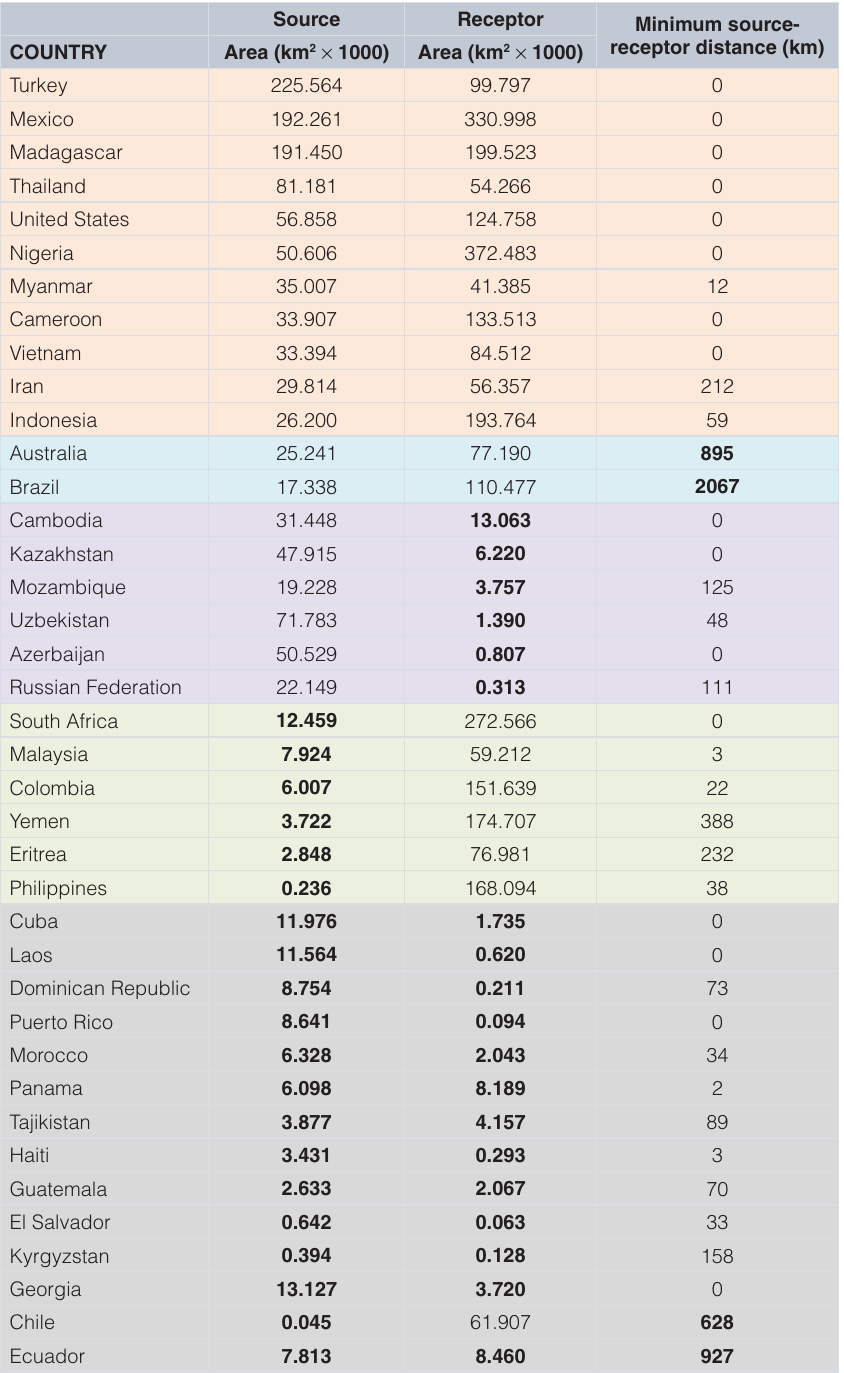
Table 1. Surface of and distances between source and receptor areas within countries where both types of areas are present. Countries were ranked from best to worst candidates based on size of source area, size of receptor area and minimum distance between the two. Orange background: best candidate countries based on thresholds of 15,000 km 2 for the areas and 500 km distance between areas. Numbers in bold correspond to limiting factors. Blue background: countries where distance between source and receptor may be limiting using the above criteria; Purple background: countries where receptor areas may be limiting; Green background: countries where receptor areas may be limiting; Grey background: countries where multiple limiting factors exist. Min. source-receptor distance is the minimum distance between a patch of source area and a patch of receptor area. When source and receptor are adjacent, the minimum source-receptor distance is